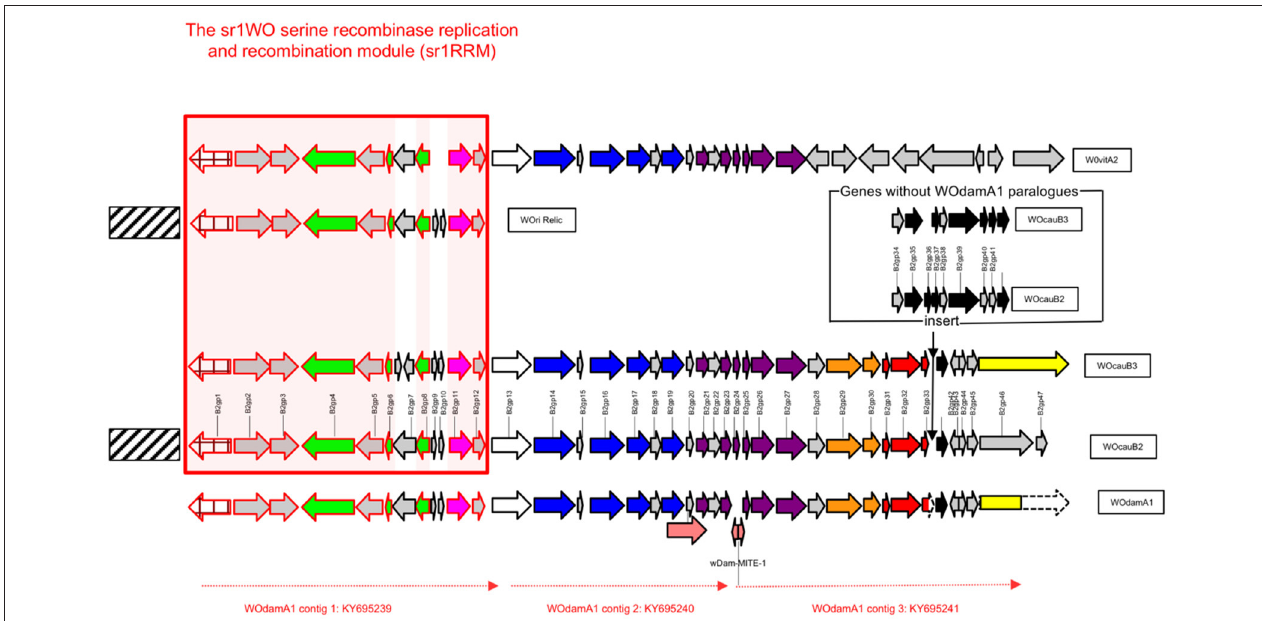
FIGURE 2 | Schematic representation of the predicted structural organization of sr1WOdamA1 in relation to all four other members of the sr1WO group bacteriophage group (sr1WO). Arrows are used to indicate the direction in which predicted gene sequences are encoded and shading is used to indicate functional homology. The gene sequences of the WOcauB2 reference genome (used in this paper and in Kent et al., 2011a) are annotated with numbers and the gene product (gp) abbreviation. A conserved block of genes spanning from WOcauB2 gp1 to WOcauB2 gp12 with functions involved in recombination and replication functions, and referred to in the main text as “sr1RMM,” is highlighted with a red box. See also Figure 1 . Nine perfectly conserved genes found within this box are indicated with pink highlighting. Predicted gene protein functional groups have been colored following the classification of Kent et al. (2011a). Blue is used to show “head” proteins; purple is used for “base-plate” proteins; orange is used for virulence proteins, and black is used for “tail” proteins. Red coloring is used to highlight a block of three predicted gene proteins, which appears only to occur in sr1WOdamA1, WOcauB2, and WOcauB3, suggesting a special relationship between these phages. The inset with WOcauB2 and WOcauB3 genes that have no WOdamA1 paralogs represents that there is no non-coding DNA separating the 3 ′ -truncated gp33 paralog and the gp42 paralog in sr1WOdamA1 contig 3. The two proposed transposable elements referred to in the main text are indicated with pink arrows; the w Dam-MITE-1 element is also labeled with its